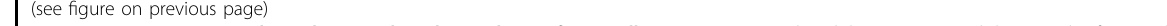
Fig. 2 RP11-295G20.2 regulates the growth and autophagy of HCC cells. a RP11-295G20.2 knockdown suppressed the growth of HCC cells, as demonstrated by CCK-8 staining assays. A total of 1000 cells were plated into 96-well plates, and the numbers of HCC cells were determined by adding CCK-8 reagent. b RP11-295G20.2 knockdown inhibited the colony formation ability of HCC cells. c RP11-295G20.2 overexpression promotes the growth of HCC cells. d RP11-295G20.2 overexpression enhances the colony-forming ability of HCC cells in vitro. e RP11-295G20.2 decreases the protein level of LC3B in HCC cells. The protein level of LC3B was determined by western blot analysis after RP11-295G20.2 overexpression or knockdown. Integrated Density Value (IDV) was obtained by ImageJ. f RP11-295G20.2 inhibits the formation of green fl uorescent protein (GFP)- tagged LC3-positive autophagosomes. g Autophagic fl ux in RP11-295G20.2 overexpressing and knockdown cells. mGFP-RFP-LC3B was introduced into HCC cells and the numbers of autophagosome (yellow dots) and autolysosomes (red dots) were counted by microscopy imaging. h Transmission electron microscopy imaging of autophgosomes in control and RP11-295G20.2 knockdown cells. i RP11-295G20.2 promotes the growth